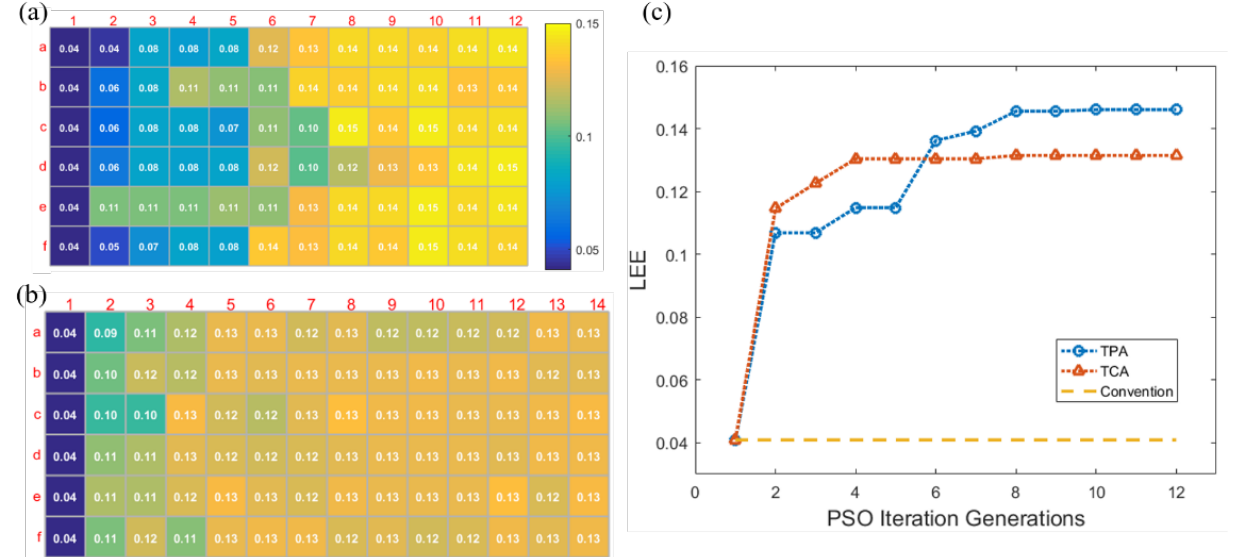
Figure 2. Updating trends of the particles in the structure of ( a ) the TPA and ( b ) the TCA, and ( c ) the comparison on the LEE enhancement trends.